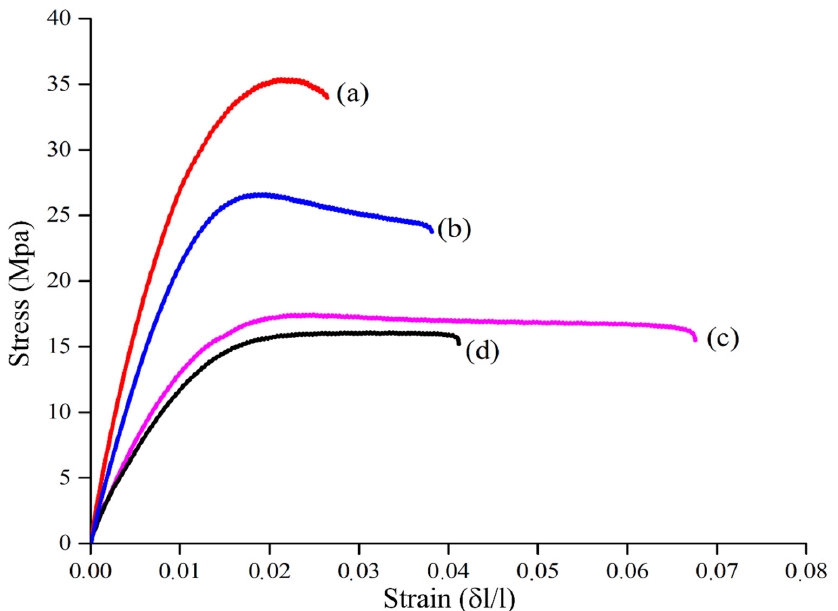
Figure 10. Stress–strain curves of composites filled with 2 wt.% of BC derived by: (a) wheat; (c) Mischantus ; stress–strain curve of composites filled with 2 wt.% of carbon black Vulcan ® 9 N115 (b); and of unfilled resin (d). Reprinted from [120] under CC BY 4.0 license .